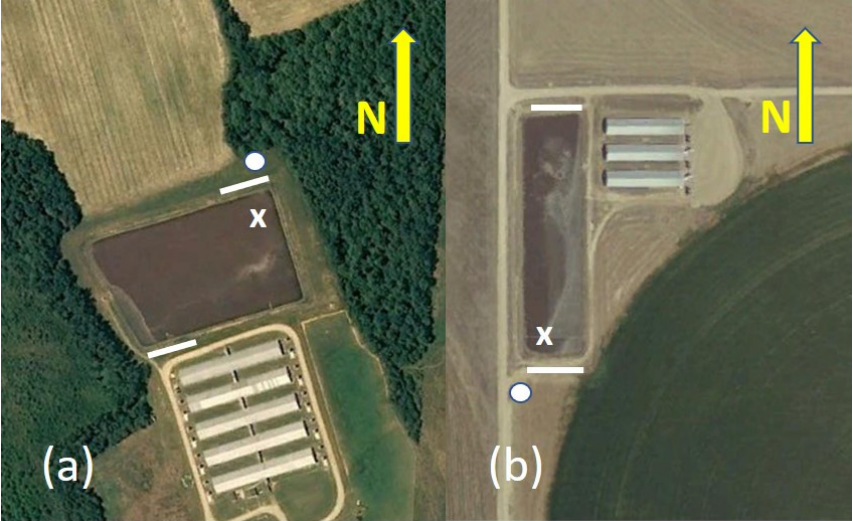
Figure 1. Lagoon and measurement configurations. The measurement configurations at the NC lagoon ( a ) and OK lagoon ( b ). Solid white lines indicate locations of S-OPS while white circles and ‘x’ indicate the locations of the meteorological and lagoon measurements respectively.